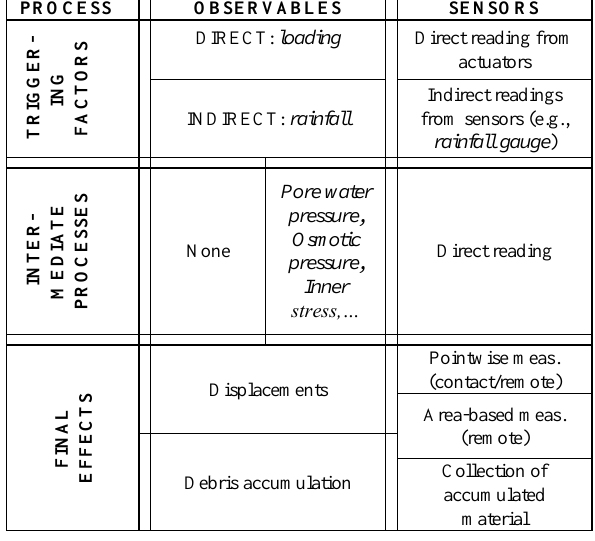
Figure 1. Workflow of possible processes and observables in experiments for hydrogeological